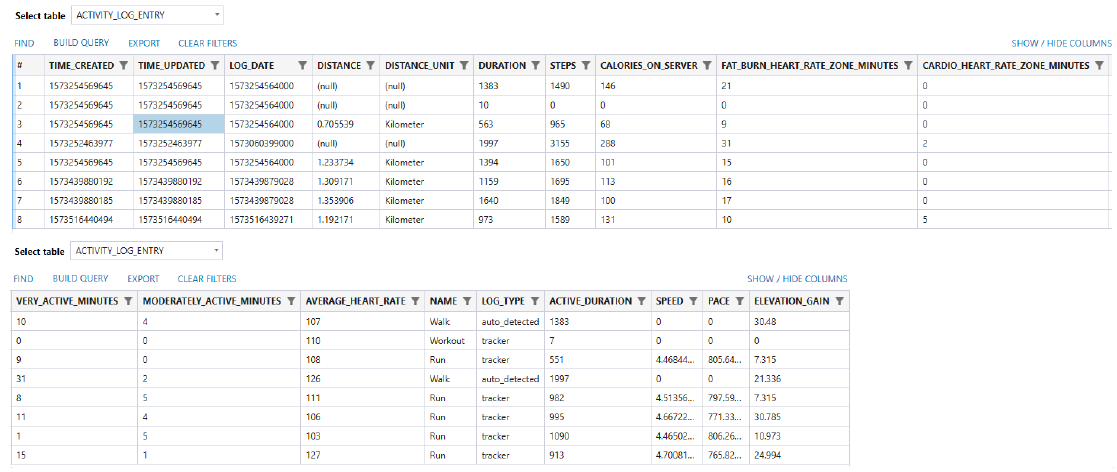
Figure 2. Heart rate data collected during exercise and activities shown in DB Browser for SQLite.